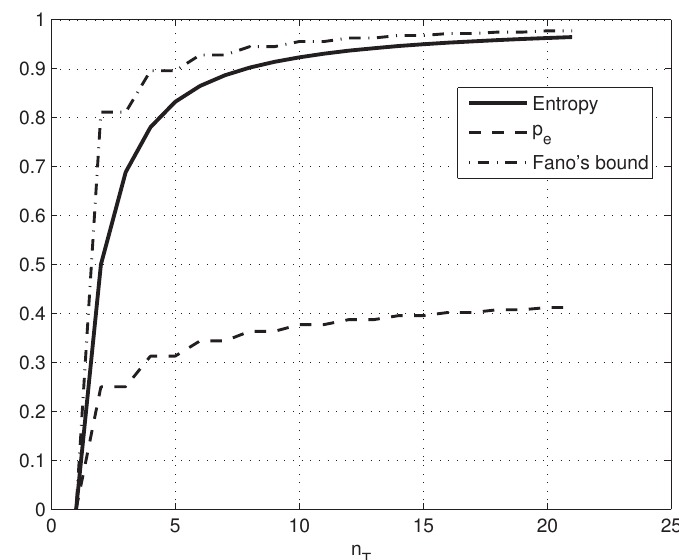
Figure 5. The conditional entropy, error and Fano’s bounds of the wiretap